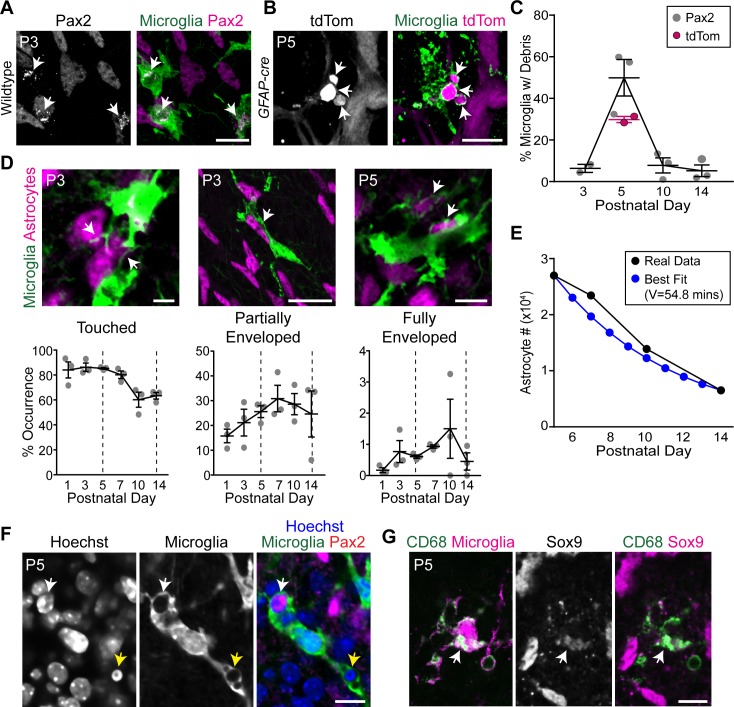
Microglia engulf developing retinal astrocytes.(A,B) Representative images showing astrocyte debris within microglia (arrows). Astrocytes labeled with antibody against Pax2 (A) or with tdTomato (tdTom) Cre reporter driven by GFAP-cre (B). This Cre line is selective for astrocytes at P5 and is not yet expressed by Müller glia [30]. Microglia labeled with anti-GFP in Cx3cr1CreER-ires-YFP mice (A) or antibodies to Iba-1 and P2Y12 (B). (A) single optical plane; (B) Z-projection of three optical planes (1.2 μm Z-distance total). Also see S4 Fig for 3D reconstructions of astrocyte debris within microglia. (C) Percentage of microglia containing astrocyte debris peaks at P5, coinciding with peak astrocyte number. (D) Astrocyte–microglia interactions quantified in Cx3cr1CreER-ires-YFP mice. Bottom row, percentage astrocyte somata touched, partially enveloped, or fully enveloped by microglial processes. Examples of each interaction category are shown (top row; arrows). Dashed lines: start (P5) and end (P14) of astrocyte loss. Phagocytosis-like interactions (i.e., partially or fully enveloped astrocyte somata) peak during the death period. Also see S1 Movie, S2 Movie and S3 Movie for 3D reconstructions of microglia–astrocyte interactions. (E) Modeling suggests that engulfment rate is sufficient to account for developmental changes in astrocyte population size. Black, observed astrocyte number from Fig 1G. Blue, best-fit model using average frequency of engulfment determined in (D) (“fully enclosed” category) as death rate parameter. The clearance time parameter of best fit model (54.8 minutes) is plausible given past studies [18,49]. (F) Engulfed astrocytes do not have pyknotic nuclei. White arrow, non-pyknotic astrocyte nucleus within a microglial phagocytic cup. Yellow arrow, non-astrocytic pyknotic nuclei within phagocytic cup of the same microglial cell. A single optical plane is shown. Microglia are labeled with Cx3cr1CreER-ires-YFP. (G) Astrocyte debris (arrow) within CD68+ lysosomal compartments of Cx3cr1CreER-ires-YFP microglia. All images are en face views of whole-mounted retina. Error bars, mean ± SEM. Sample sizes are depicted by data points on graphs. For data plotted in graphs, see S1 Data. Scale bars, 5 μm (D, left); 10 μm (D, right; F; G); 25 μm (A; B; D, center). GFP, green fluorescent protein; tdTom, tandem dimer Tomato; YFP, yellow fluorescent protein.